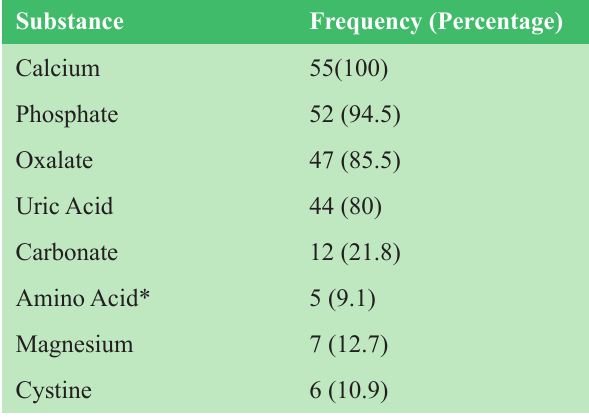
Table 2 Distribution of chemicals in 55 stones